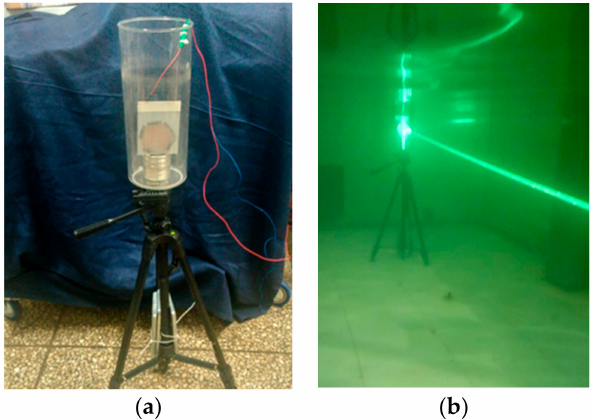
Figure 20. Preliminary communication experiment. ( a ) The MRR used in the experiment, which contains a CCR behind a PDLC film; ( b ). MRR operating during the